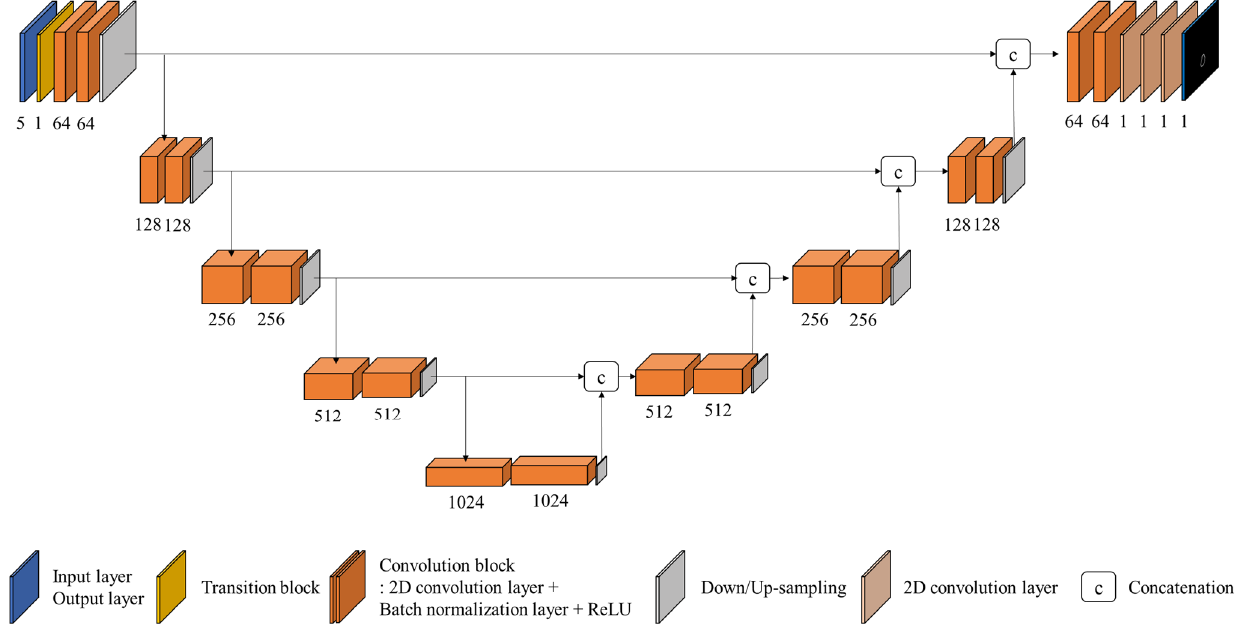
Figure 3. Diagram of the interobserver variability prediction network (IOV-Net) based on the U-Net with the pseudo-3D